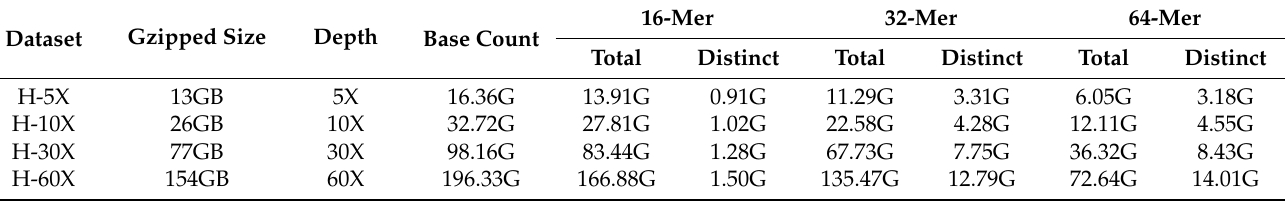
Table 4. Datasets downloaded from the public database ( H. sapiens ). H.1: